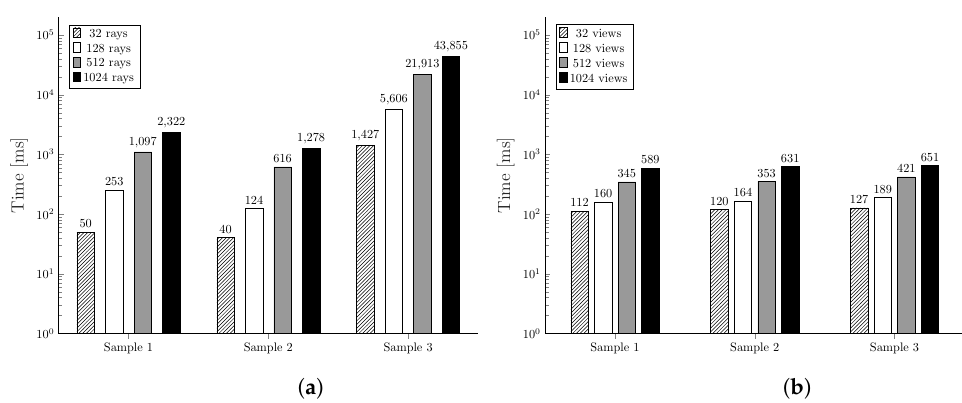
Figure 16. Computation time comparison of the two algorithms using different settings and samples. ( a ) shows the results obtained with Plücker VSD, ( b ) shows the results obtained with MeshLab VSD. However, the time needed to perform VSD is not of particular interest for this